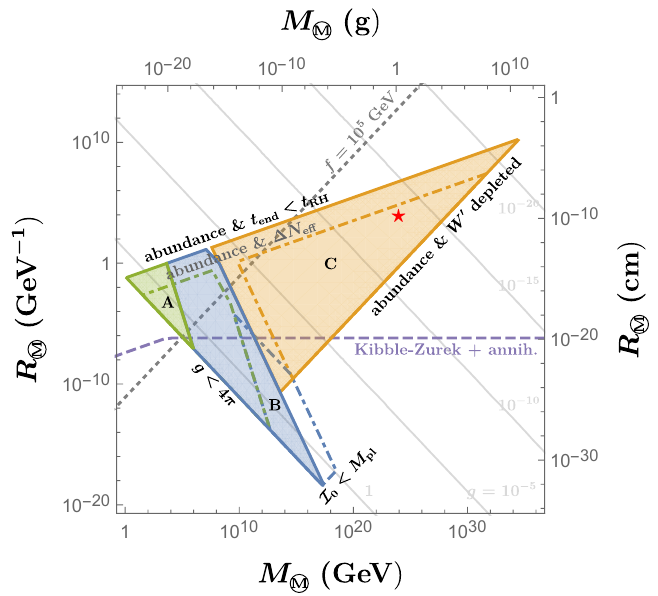
Figure 4 . Regions (shaded) where dark monopoles can make up all of DM if produced via paramet- ric resonance in M (cid:25) 4 (cid:25)f=g and R (cid:25) ( gf ) (cid:0) 1 . Here, T RH = 1 MeV, q 0 = 10 3 , and (cid:21) = g 2 have M M been assumed, marginalizing over all possible (cid:21) I (cid:30) . The shaded regions show H I = H high , while I dot-dashed regions show H low . In the orange \C" region, the dark sector is out of both kinetic I and chemical equilibrium. The blue \B" region has only chemical equilibrium, while the green \A" region has both chemical and kinetic equilibrium. The purple dashed line shows the result from the Kibble-Zurek production mechanism with a second-order thermal phase transition and subsequent dark monopole annihilations, with (cid:20) (cid:17) T 0 =T = 1 = 10. Above this line, dark monopoles only account for a fraction of total DM. The gray dotted line shows f = 10 5 GeV; for smaller f above this line, monopoles will not have EW-symmetric cores while maintaining (cid:21) (cid:30)h small enough to decouple the dark sector from the SM (see text for details). The light gray lines show contours of (cid:12)xed g varying from 1 to 10 (cid:0) 20 from bottom to top in factors of 10 (cid:0) 5 .